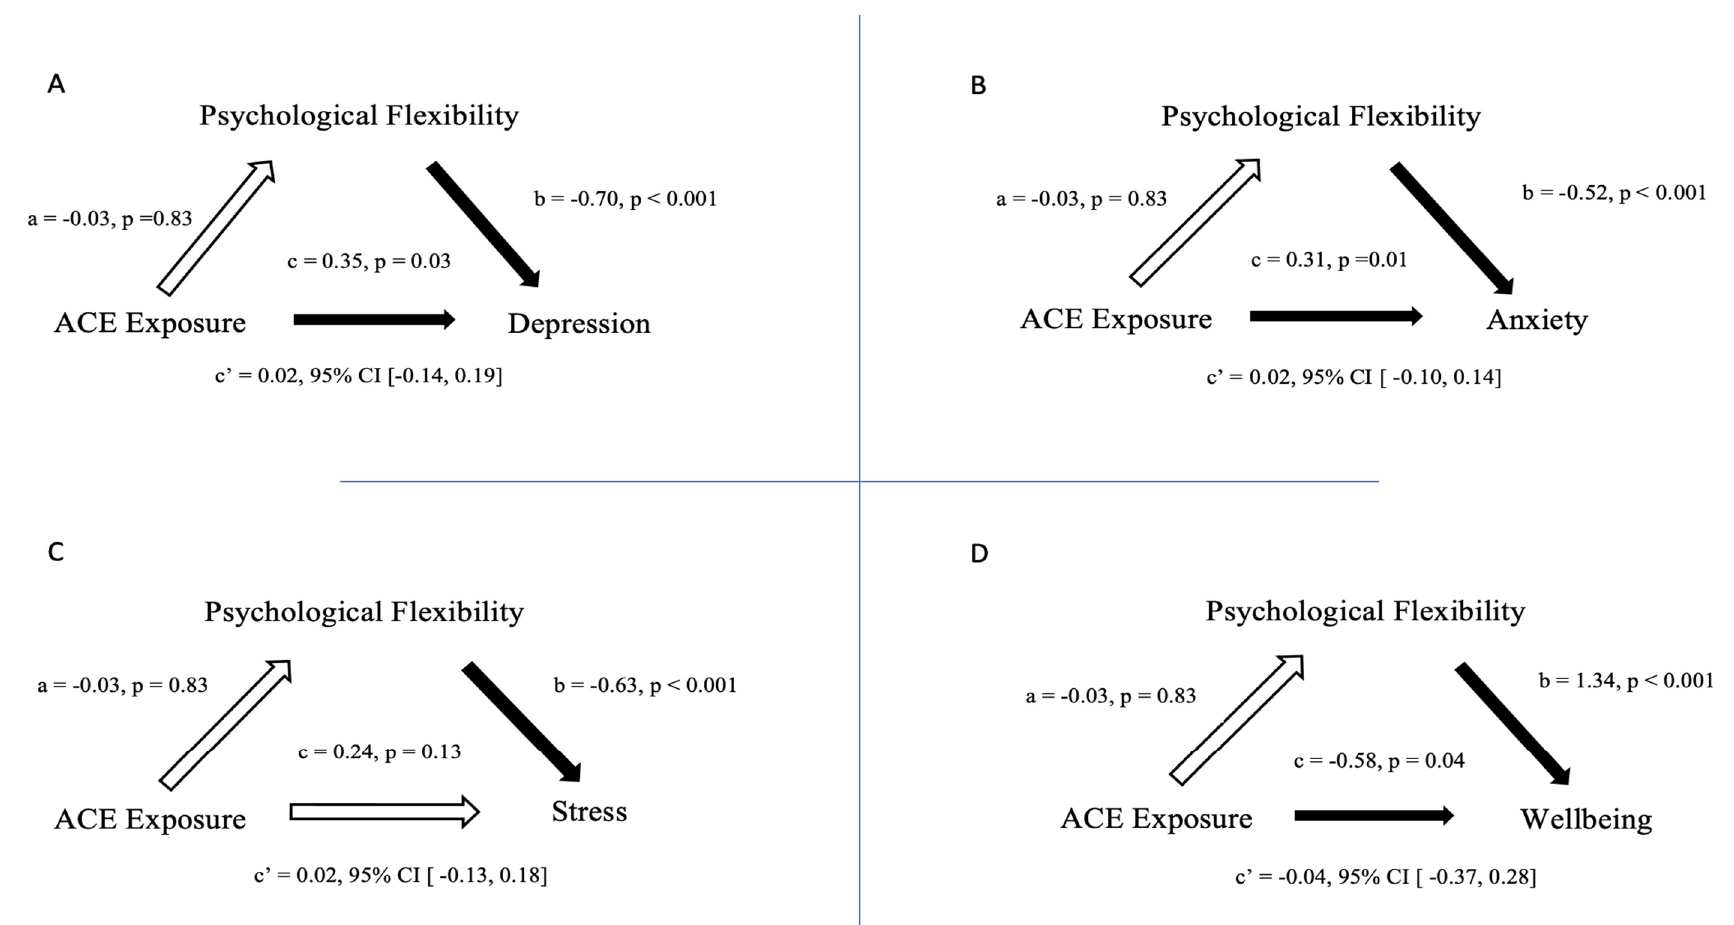
Figure 1. Mediation Analyses. Each quadrant represents a mediation analysis with ACE Exposure (ACE Questionnaire total) as a constant predictor variable with Psychological Flexibility (PsyFlex outcome) as a constant mediator variable. The outcomes change as follows: ( A ) Depression (DASS-21); ( B ) Anxiety (DASS-21); ( C ) Stress (DASS-21); and ( D ) Wellbeing (WEMWBS). Note: “c” refers to bivariate effect of predictor on outcome; “c’” refers to bivariate effect of predictor on outcome while controlling for the mediator. Arrows: hollow (white) arrows indicate a non-significant mediation effect, with filled (black) arrows indicating a significant relationship.